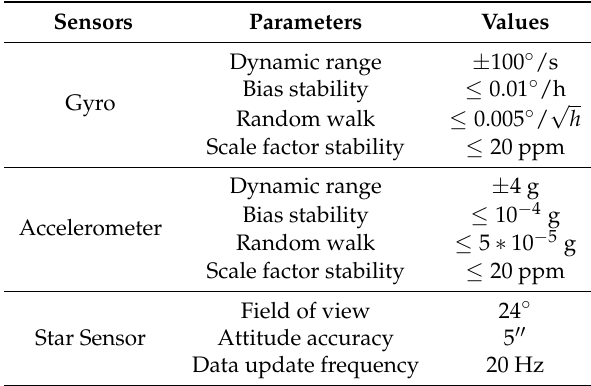
Figure 5. The IMU ( left ) and GPS ( right ) used in the experiments. Table 3. Main parameters of the SINS and star